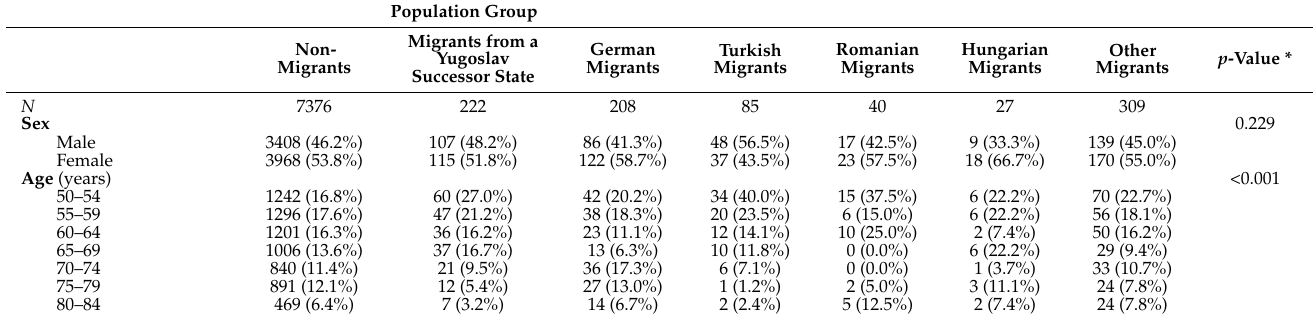
Table 1. Description of the study sample by population group (Austrian Health Interview Survey 2019, respondents aged 50 years and over, n =